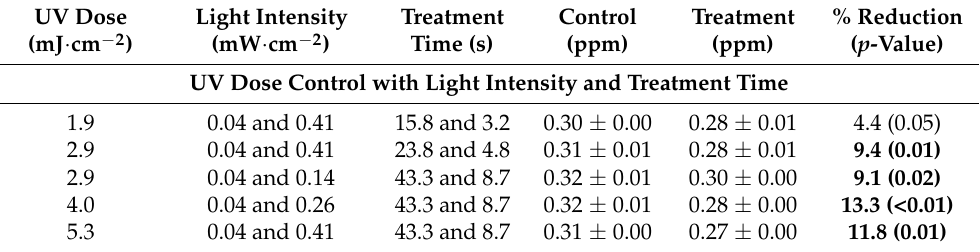
Table 3. Mitigation of N 2 O with UV-A photocatalysis treatment. Control temperature = 28.5 ± 2.3 ◦ C, in the table are mean ± S.D. Bold signifies statistical significance.